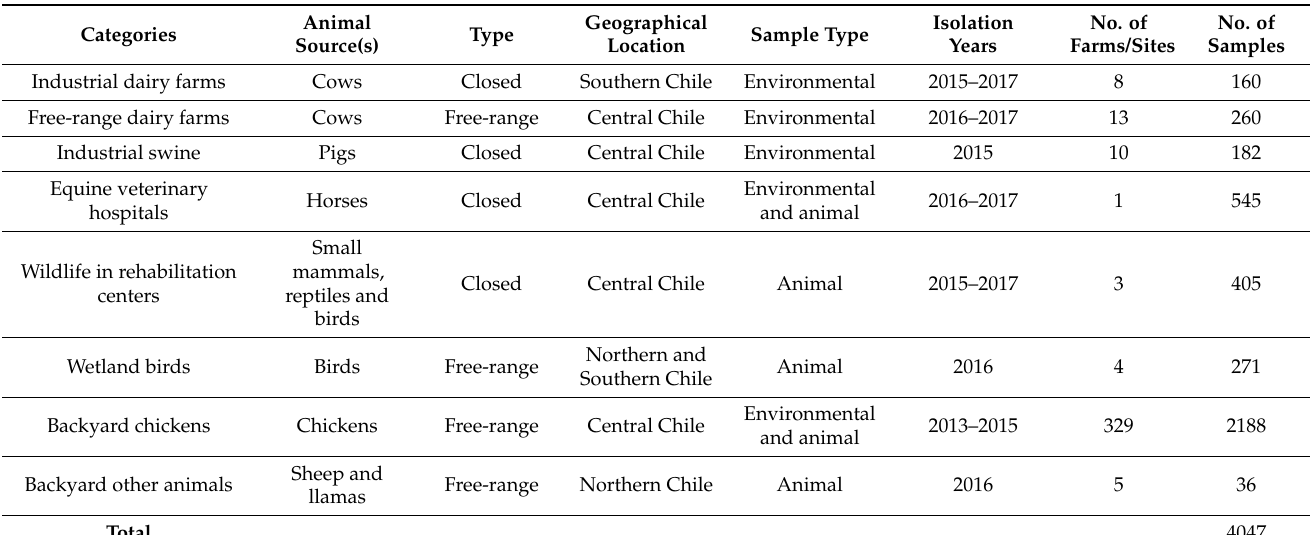
Table 1. Characteristics of the study sites where samples were